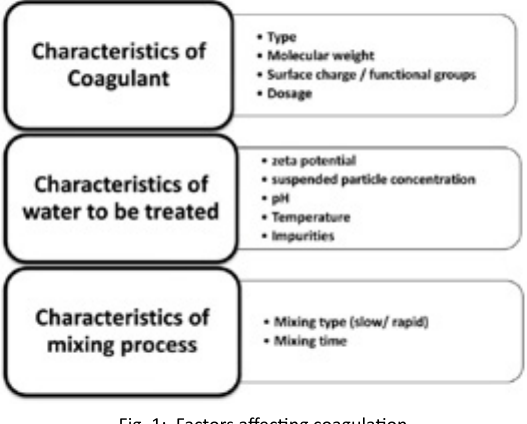
Fig. 1: Factors affecting coagulation (Ang et al ., 2020; Gautam and Saini, 2020; Kumar et al ., 2017)